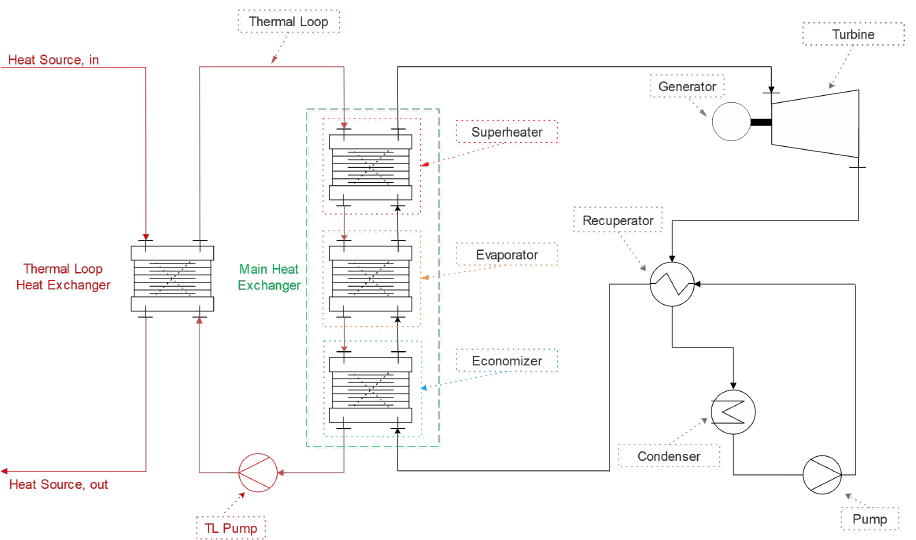
Figure 2. The layout of the recuperative ORC unit equipped with the thermal loop and the water- cooled